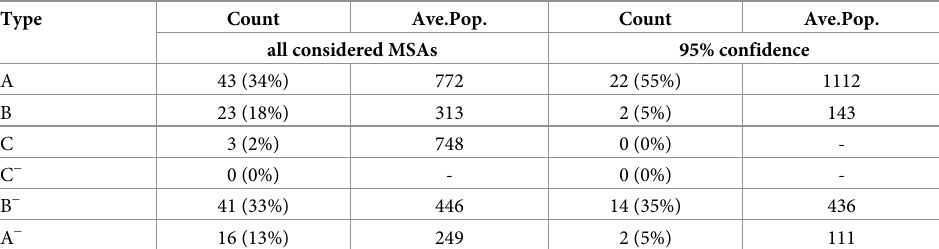
Table 2. Occurrences of the development types detailed in Table 1. Type Count Ave.Pop. Count Ave.Pop. all considered MSAs 95% confidence A 43 (34%) 772 22 (55%) 1112 B 23 (18%) 313 2 (5%) 143 C 3 (2%) 748 0 (0%) - C − 0 (0%) - 0 (0%) - B − 41 (33%) 446 14 (35%) 436 A − 16 (13%) 249 2 (5%) 111 ‘all considered MSAs’ refers to the entire set of 126 MSA and ‘95% confidence’ refers to only those 40 MSA where confidence from bootstrapping is at least 95%. ‘Ave.Pop.’ stands for average population of the MSA (2010) in multiple of 1,000. Almost half of the MSA are of types A − , B − , or C − , exhibiting increasing shares of agriculture GDP. MSAs of type A are the largest in terms of population.